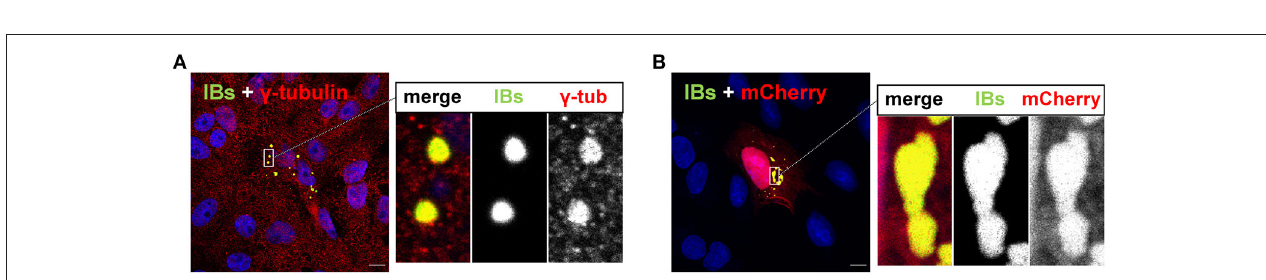
FIGURE 2 | Cytosolic IBs formed by NiV N and P proteins contain γ -tubulin and sequester mCherry. (A) Vero76 cells were transfected with plasmids encoding NiV N and NiV PeGFP. 24h p.t. cells were fixed with 4% PFA and permeabilized with methanol/acetone. The MTOC component and aggresome marker γ -tubulin was labeled with an anti- γ -tubulin antibody (red). IBs were detected by eGFP autofluorescence (green). (B) Cells were transfected with plasmids encoding NiV N, NiV PeGFP and mCherry. Cells were fixed with 4% PFA at 24h p.t. and IBs (green) and mCherry (red) were detected by autofluorescence. Nuclei were counterstained with DAPI (blue). Scale bars, 10 µ m. The magnified area in the right panel highlights the IBs and also shows the single channel greyscale images of the labeled proteins.